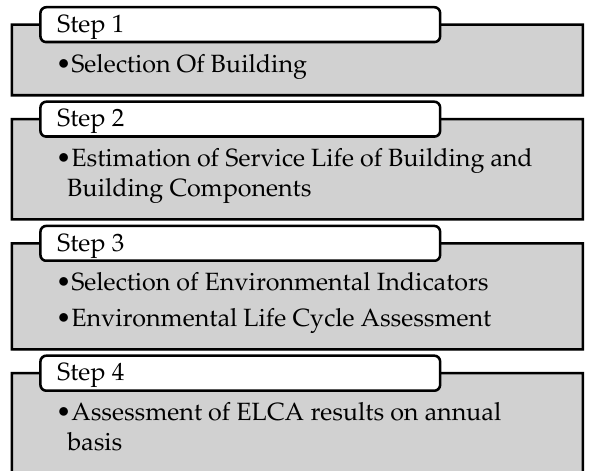
Figure 1. Building environmental performance assessment procedure.